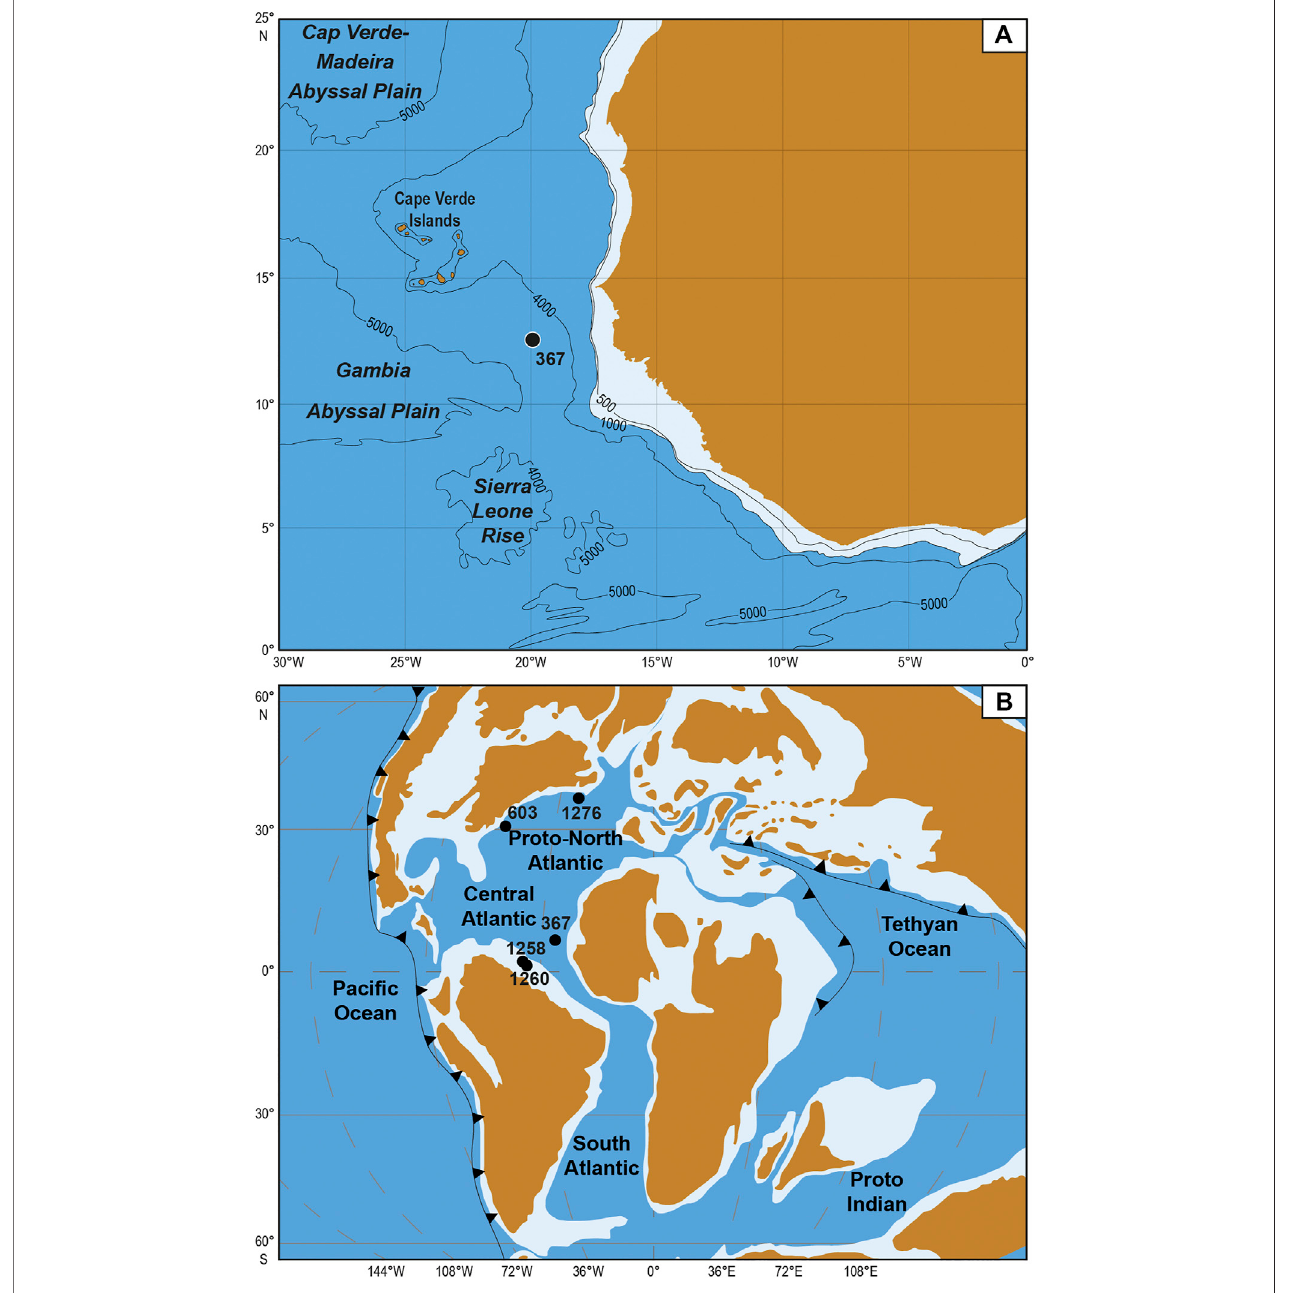
FIGURE 1 | Location of the DSDP site 367 in the Cape Verde Basin (modi fi ed from Lancelot et al., 1978) (A) and paleomap of the Cenomanian-Turonian Central Atlanticandproto-NorthAtlanticzoneswiththepaleopositionsofthesite367andotherDSDP/ODPsites(603,1258,1260,and1276)mentionedinthispaper(vanHinte et al., 1993; Erbacher et al., 2004a, Erbacher et al., 2004b; Tucholke et al., 2004) (B) .